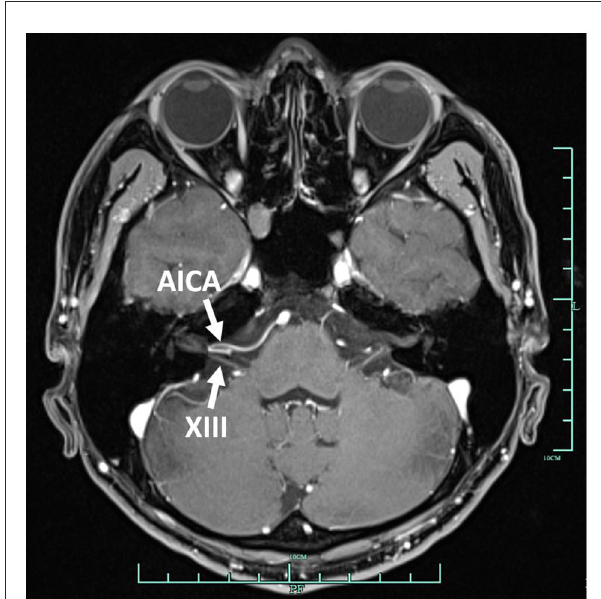
FIGURE1 Contrast enhancement MRI of the internal auditory canal. The right AICA compressed the vestibulocochlear nerve. AICA, anterior inferior cerebellar artery; XIII, vestibulocochlear